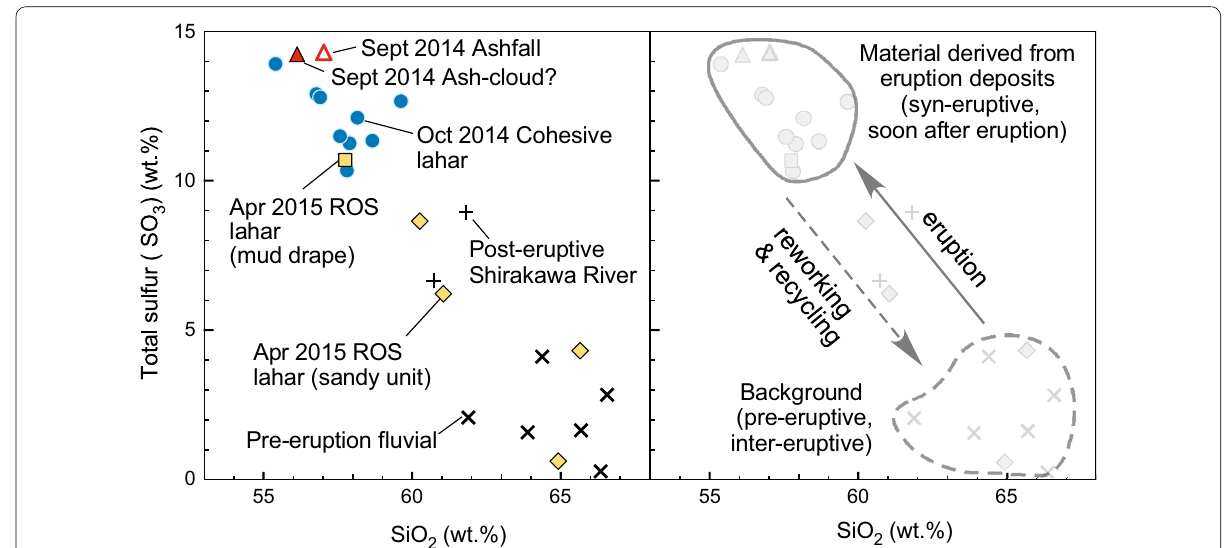
Fig. 8 Plot showing total sulfur content (as SO 3 ) versus SiO 2 content in ashfall, October rain-triggered and April ROS-triggered lahars, and pre-eruptive fluvial deposits